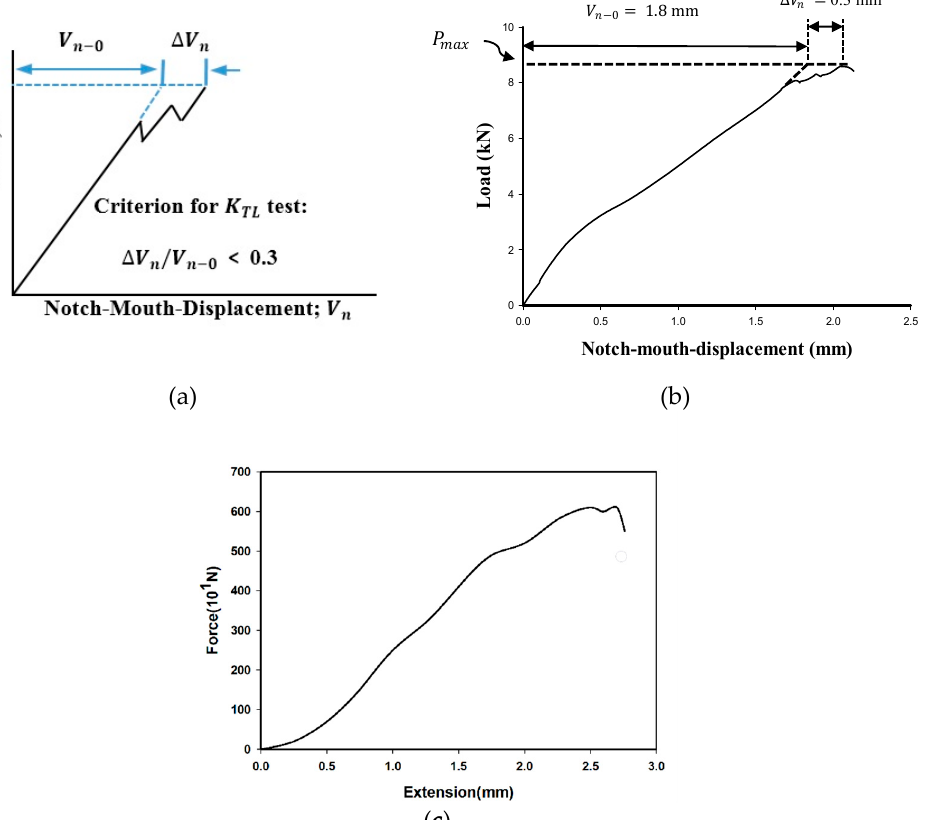
Figure 2. ( a ) Schematic of the load versus the NMD according to the ASTM E1922 [38]; ( b ) a sample load versus the NMD curve corresponding to the quasi-isotropic laminates. ( c ) The load–displacement curve for U-notched cross-ply configuration with a notch radius of 1 mm. Table 1. Mechanical properties of the tested laminates (16 layers on each lay-up